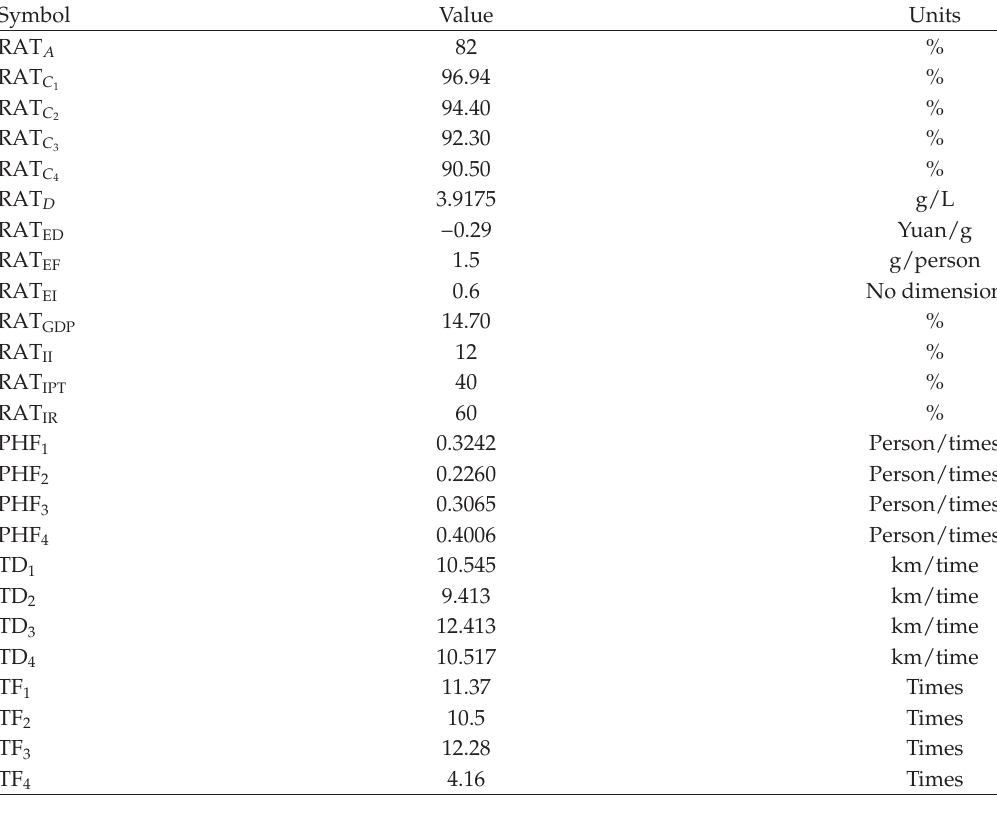
Table 2: The value of parameters.